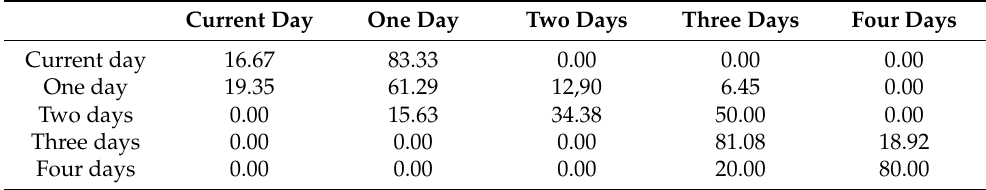
Table 3. Prediction results obtained using the average of the differences between R and G in RGB values with noise.